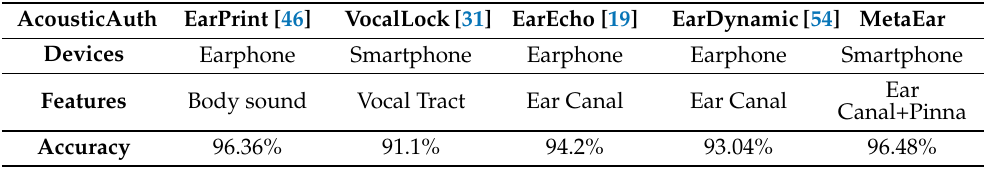
Table 2. Comparison of Different Acoustic Biometric